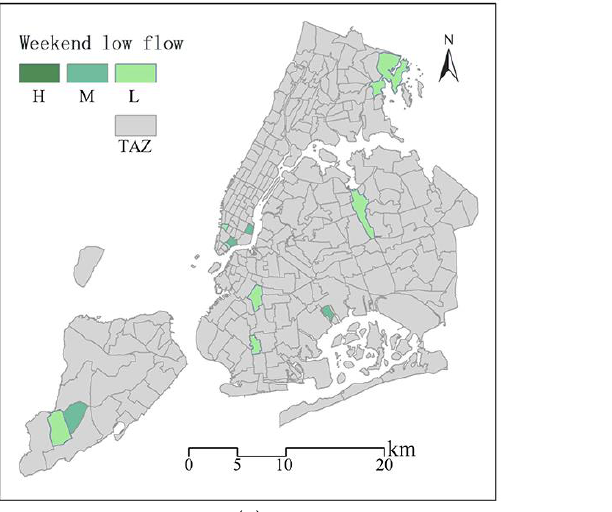
Huaqiang North Business District, Fukuda Port, Dongmen Old Street Business District